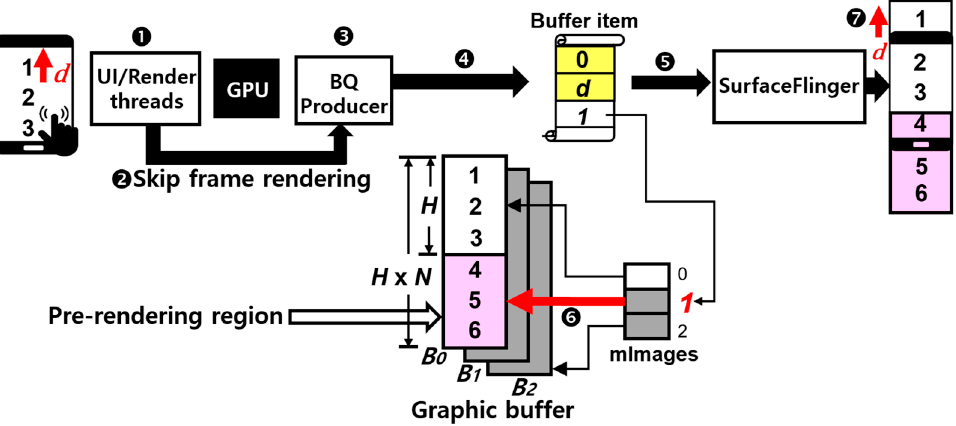
Figure 4. Overview of SCAR.